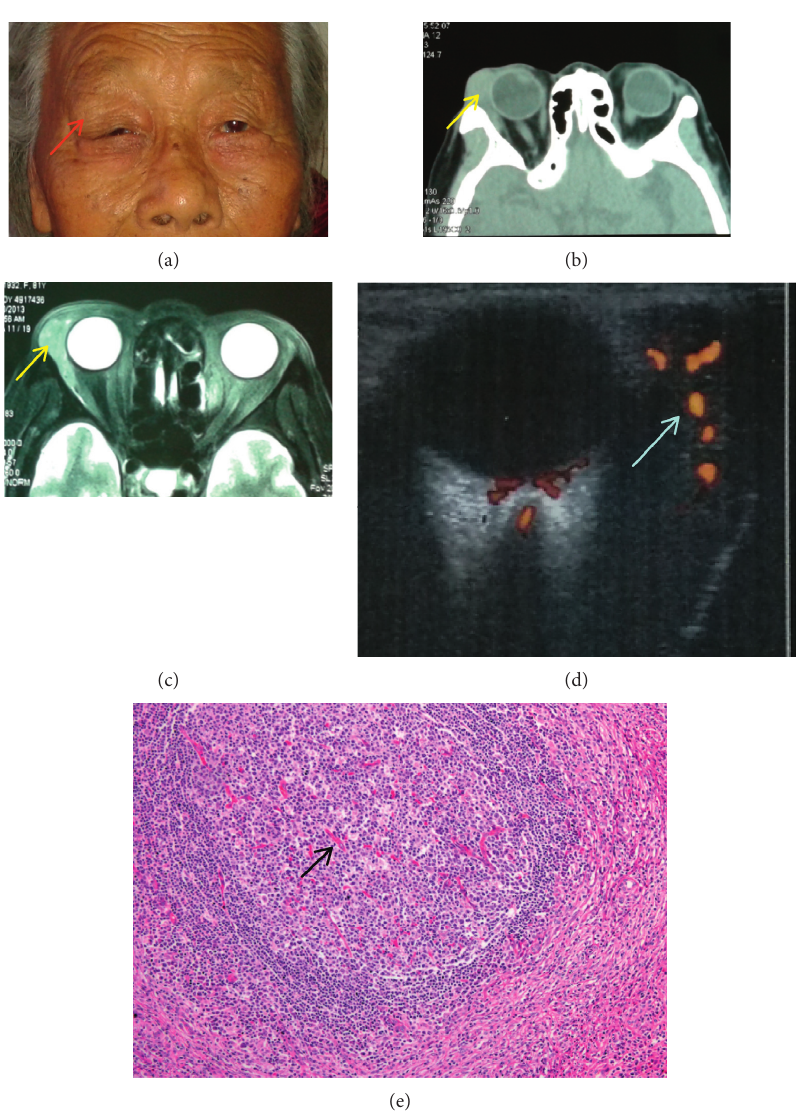
Figure 1: (a), (b), (c). Preoperative appearance of the right eye. CT and MRI showed a swollen mass in the lacrimal gland area (red and yellow arrows). (d) Color ultrasonography showed a mass in the lacrimal gland area of the right eye with abundant blood flow (blue arrow). (e) Small blood vessels were observed invading the germinal center (black